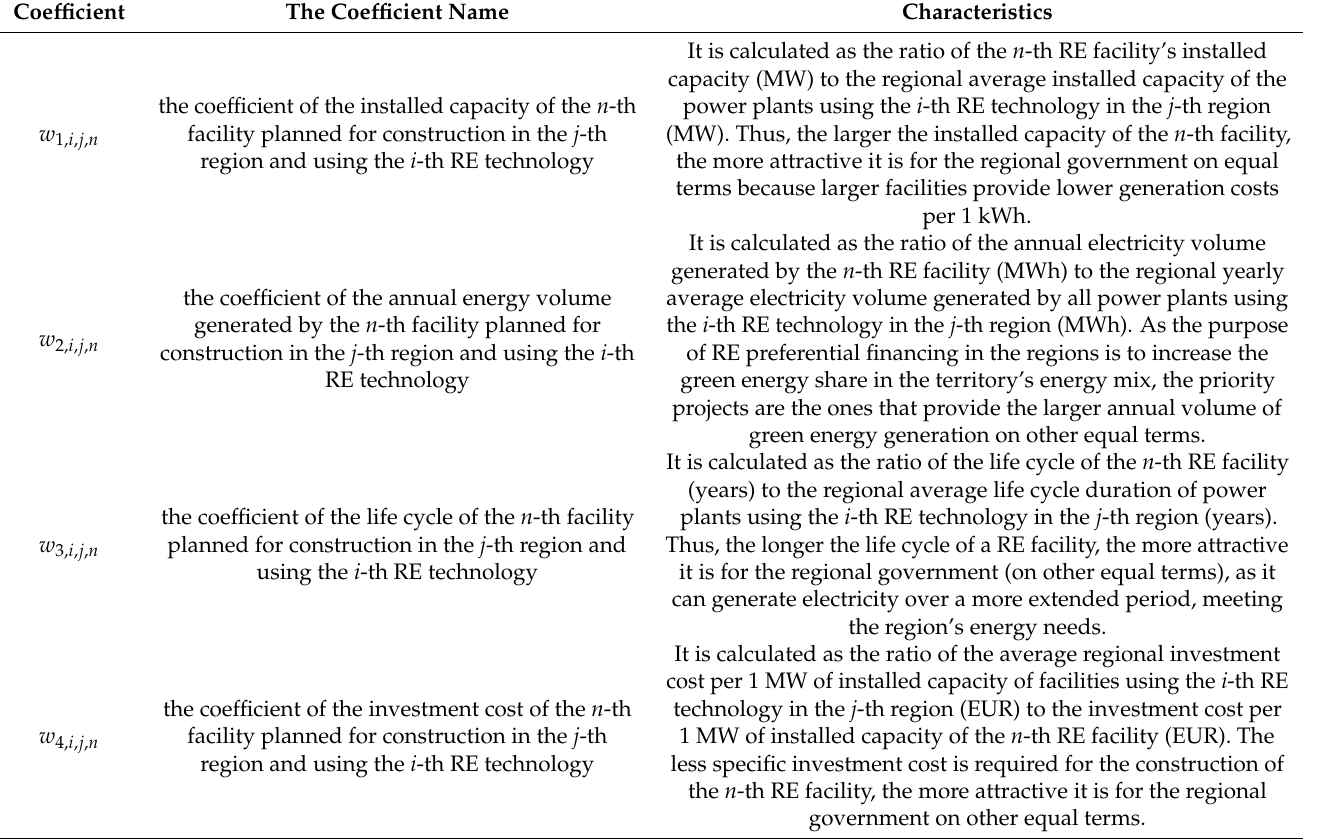
Table 2. Characteristics of the coefficients w l , i , j , n (developed by the